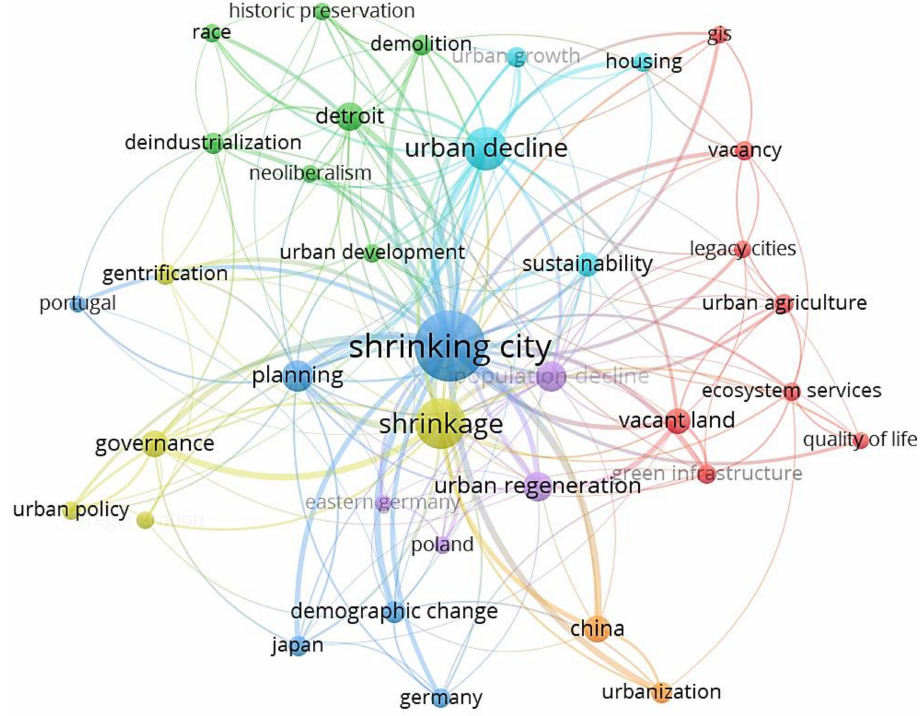
Figure 7. Co-occurrence of keywords in SCT